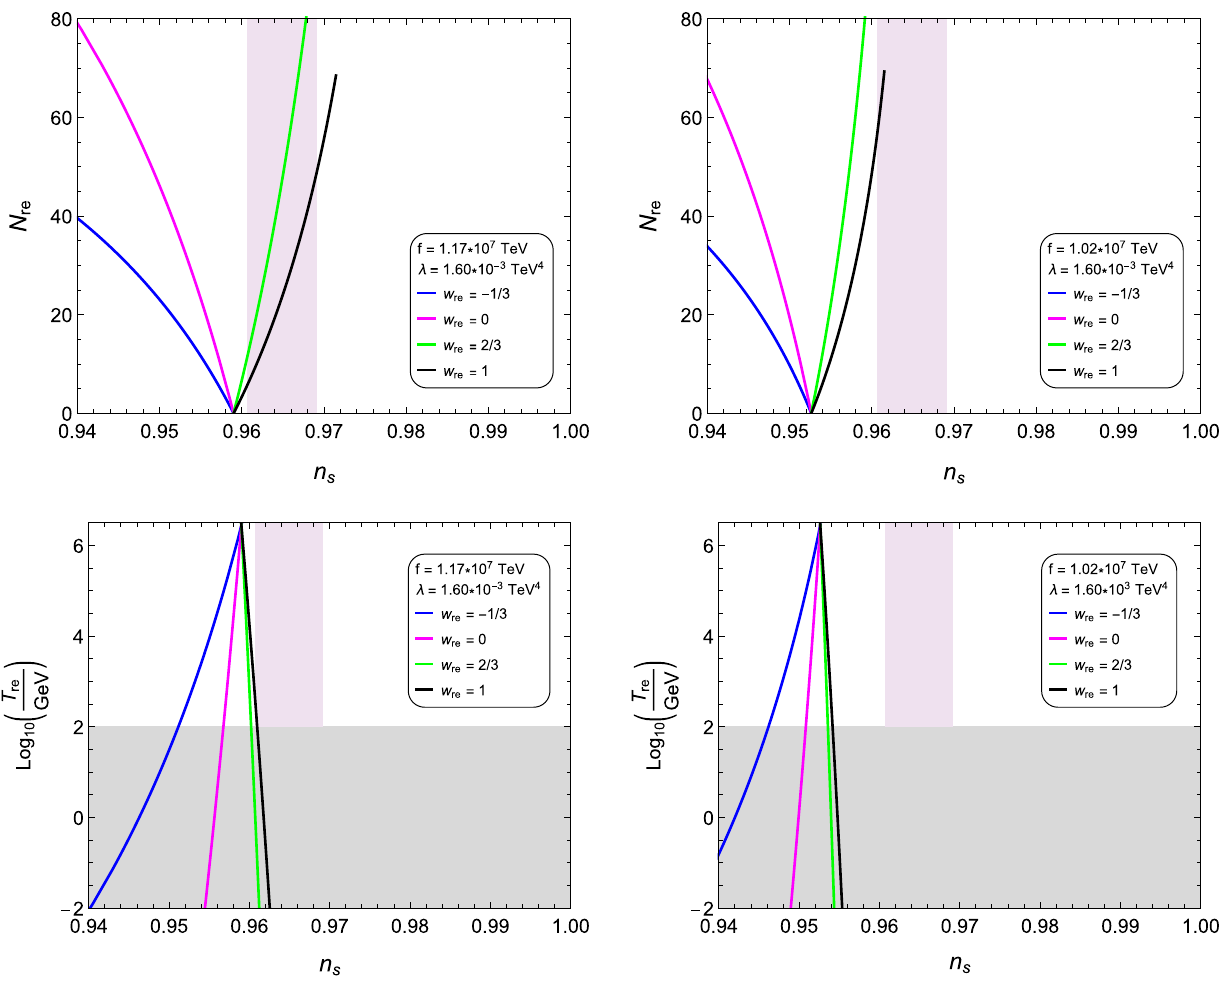
Fig. 3 Plots of N re and T re as functions of n s using the lower limit of the five-dimensional Planck mass ( M 5 = 10 5 TeV) for Natural infla- tion.Theblue,pink,greenandblackcurvescorrespondstothefollowing values of the EoS parameter: w re = − 1 / 3, 0, 2 / 3 and 1, respectively. The purple region indicates the observational constraints on the spec-